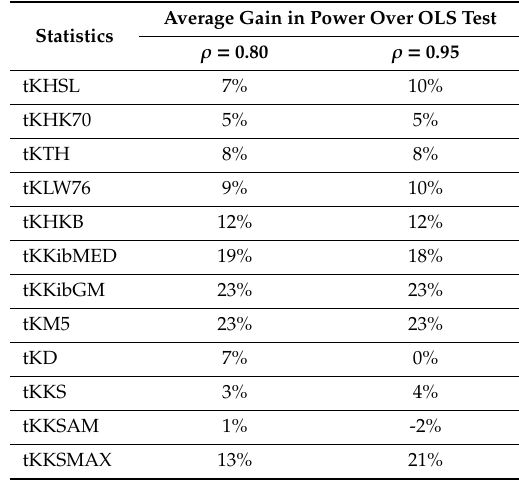
Table 7. Average gain in power over the ordinary least squares (OLS) test for α = 0.05 and q = 0.06.